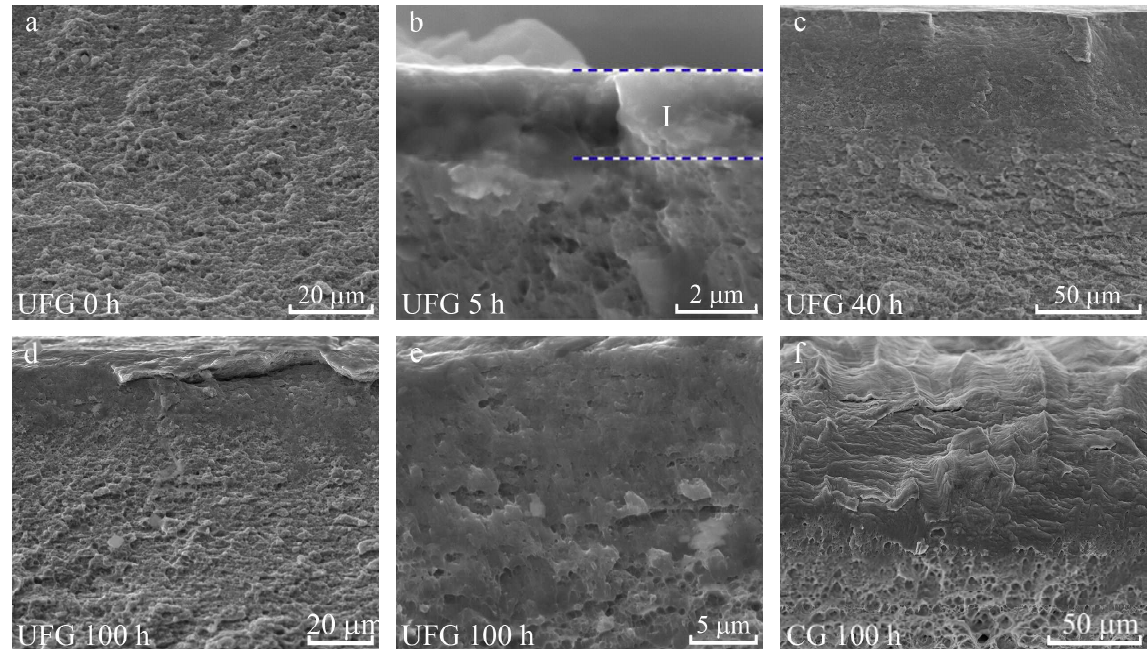
Fig. 12. SEM micrographs of the fracture surfaces of the UFG-CrNiMo (a-e) and CG-CrNiMo (f) steel specimens depending on hydrogen-charging duration: a – hydrogen-free, b – hydrogen-charged for 5 hours, c – hydrogen-charged for 40 hours, d, e, f – hydrogen-charged for 100 hours. Image (e) is magnified element of the near surface area on image (d).